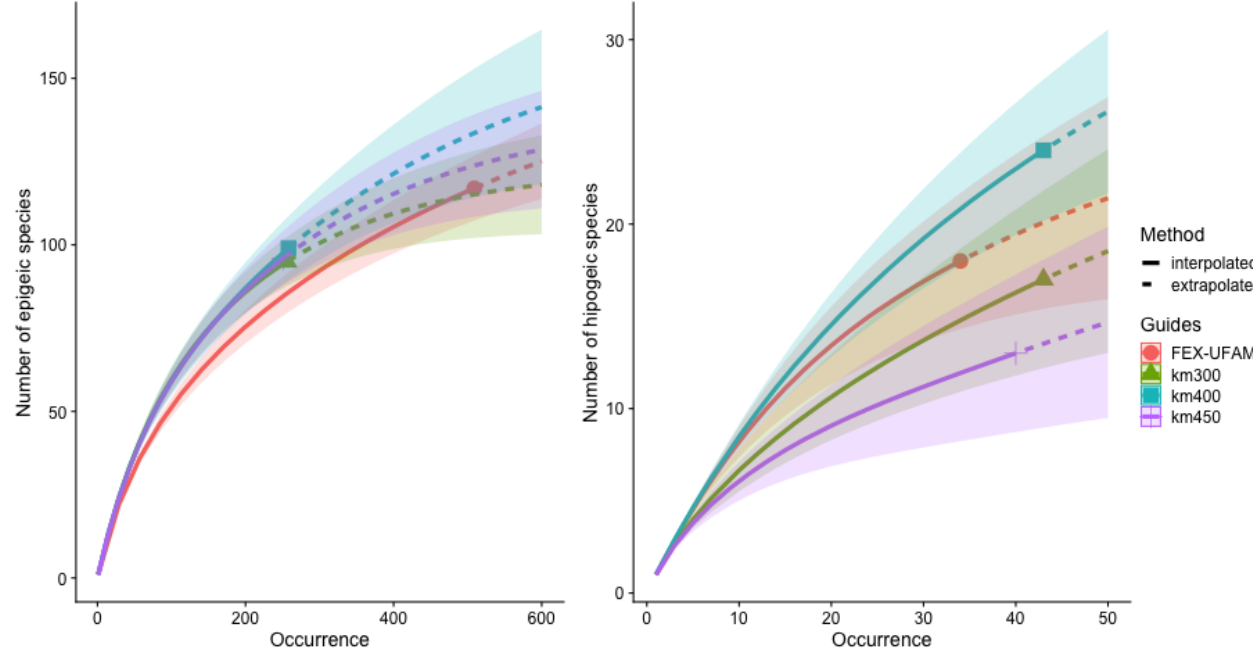
Fig 3 . Species accumulation curves based on 1,000 randomization of FEX-UFAM and BR-319 modules samples, representing the epigeic and hypoggeic strata. Shaded area represent the standard deviation of the richness